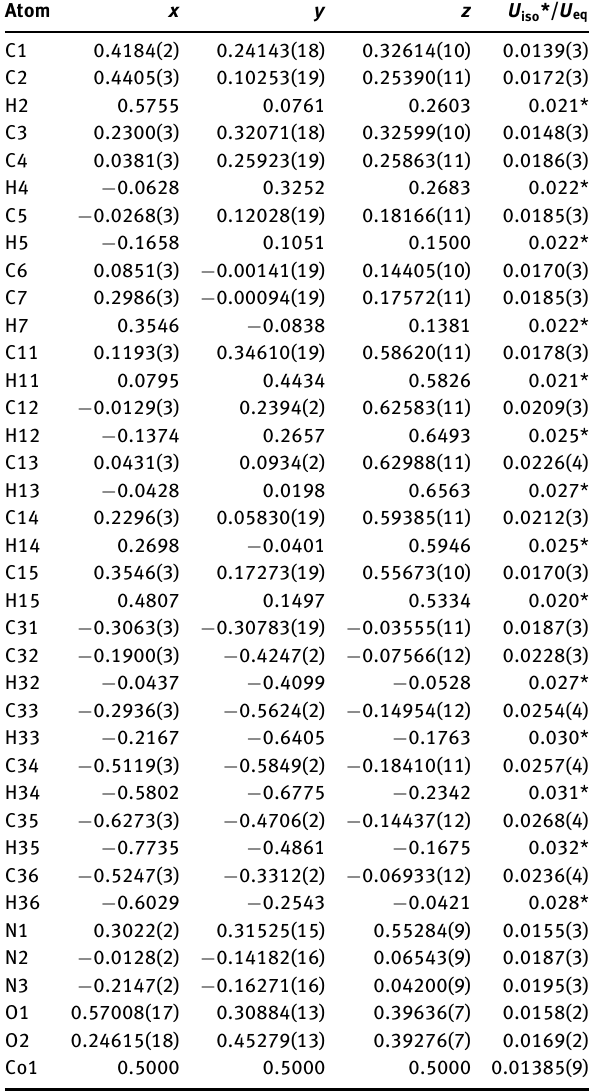
Table 2: Fractional atomic coordinates and isotropic or equivalent isotropic displacement parameters (Å 2